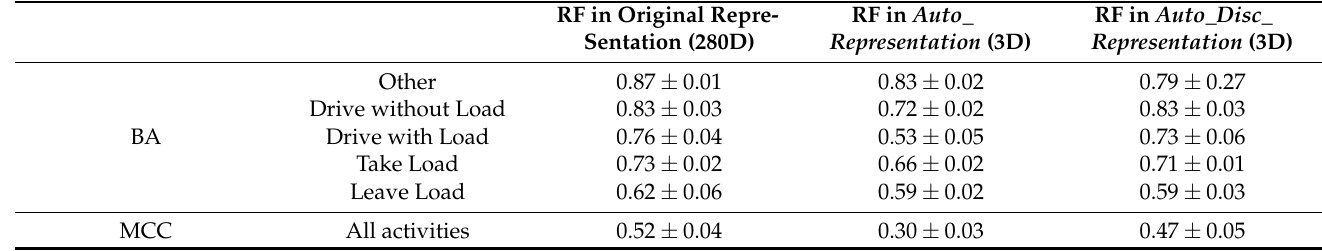
Table 1. Classification results of the RFs on top of different representations (mean ± 2 × std.) RF in Original Repre- RF in Auto_ RF in Auto_Disc_ Representation (3D) Representation Sentation (280D)